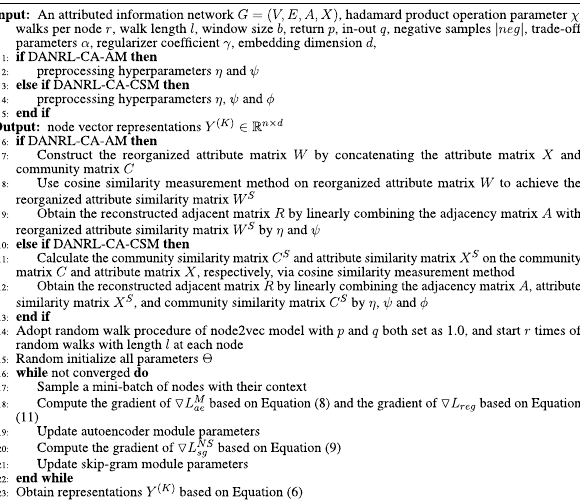
Algorithm 1. Framework of DANRL-CA